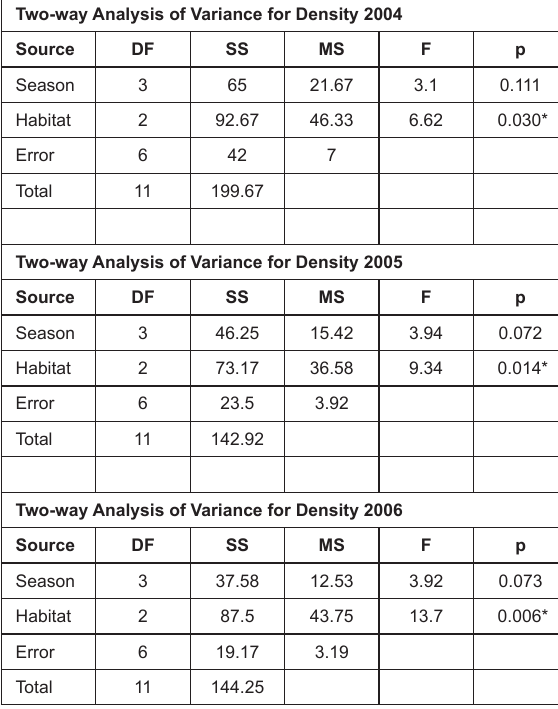
Table 3. Two-way Analysis of variance (ANOVA) to investigate the population density variations in 2004, 2005 and 2006 during different seasons and